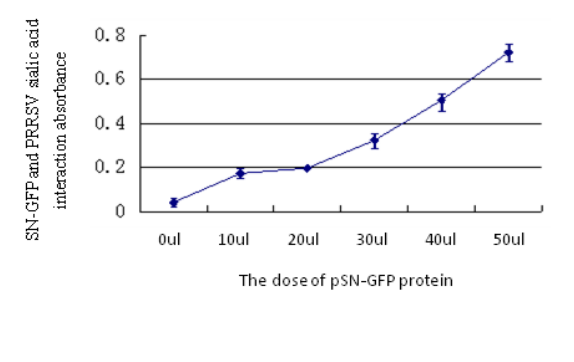
( A ) ELISA interaction standard curve ( B ) Interaction quantification using ELISA 2.2.4. Analysis of the Binding Activity of SN-GFP-M Chimeric Proteins with PRRSV Using Immunofluorescence